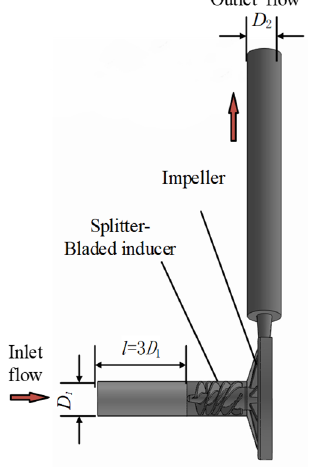
Figure 3. Calculation area.